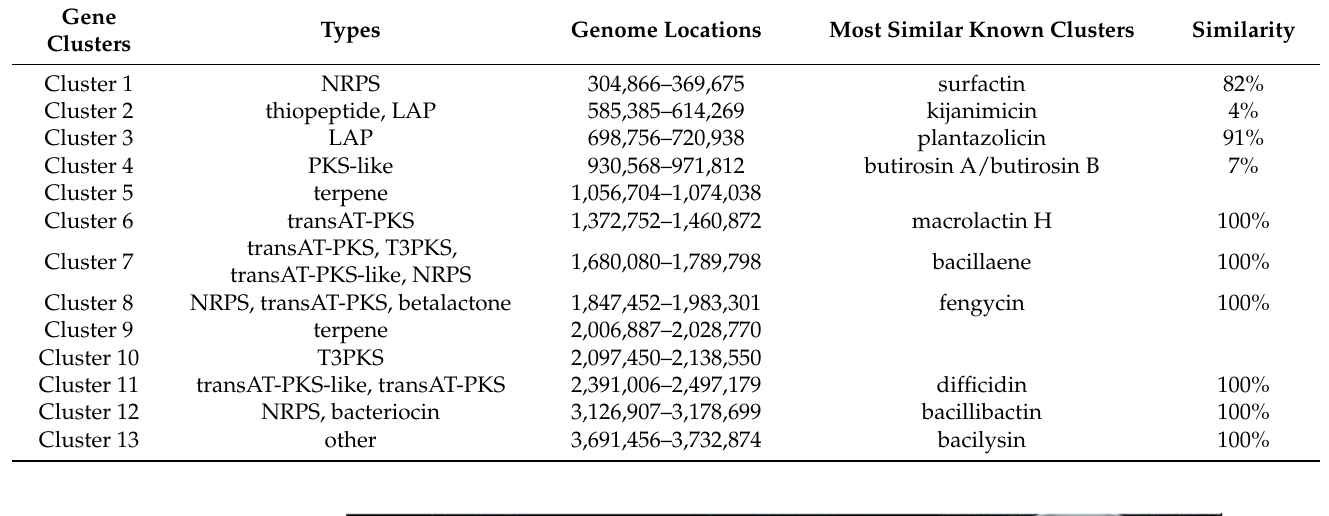
Table 1. Putative gene clusters that encoded for secondary metabolites in GS-1.